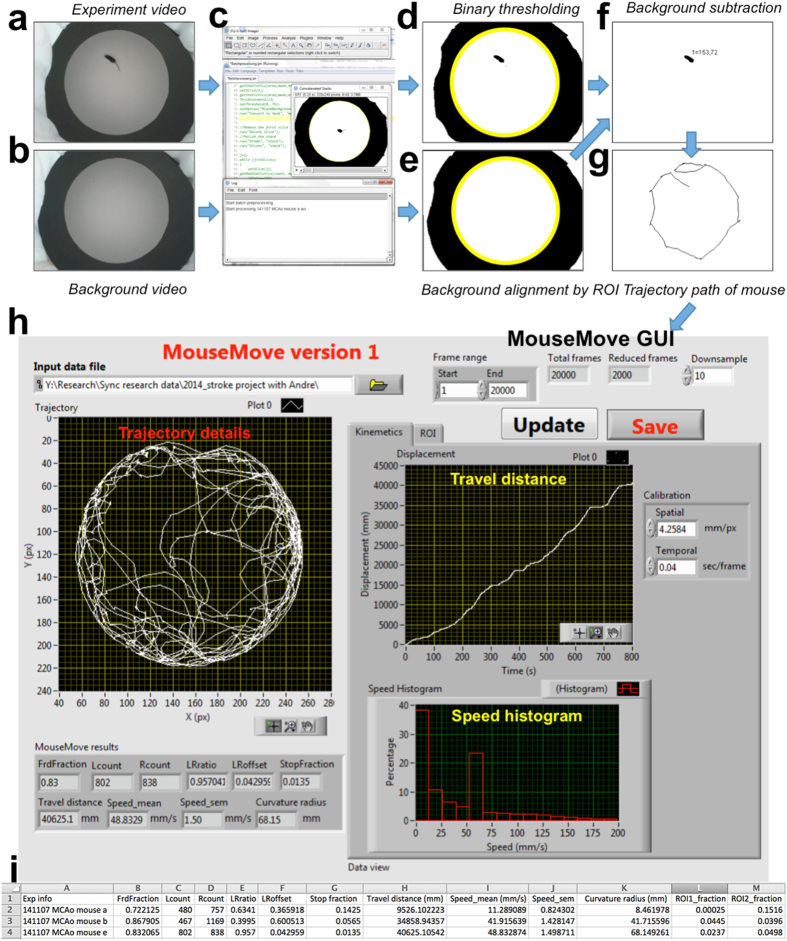
Stepwise image processing of an OF test by MouseMove.(a) Video frame of a mouse during OF testing. (b) Video frame of the empty OF. (c) Screenshot of MouseMove’s preprocessing macro into which the two videos are entered. (d) Same frame as in ‘Panel (a)’ but after binary thresholding. (e) Same frame as in ‘Panel (b)’ but after binary thresholding. The yellow rings in ‘Panels (d,e)’ indicate the perimeter of the OF as detected by MouseMove, which allows automatic spatial alignment of the two videos. (f) Same frame from ‘Panel (a)’ but after subtraction of ‘Panel (e)’ from ‘Panel (d)’. ‘1 = 153,72’ stipulates the assigned number of the measurable object (i.e. one) and its arbitrary x,y coordinates at that point in time (i.e. x = 153 and y = 72). (g) Cumulative trajectories of the same mouse over 100 s in the OF. (h) Screenshot of MouseMove’s graphical user interface (GUI) and visual depiction of the analyses performed by MouseMove for an OF test. (i) Example of MouseMove’s text file output for the OF testing of three representative MCAo-operated mice.